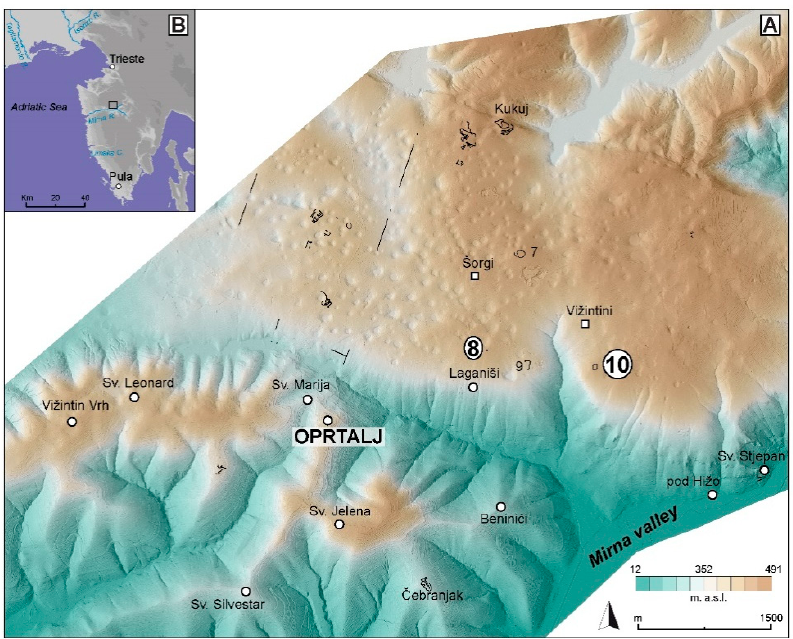
Figure 1. ( A ) Position of the investigated sites 8 and 10, main archaeological sites (white dots and black lines; see Bernardini and Vinci [23]) and modern localities mentioned in the text (white rectangles). ( B ) Position of the area in the Istrian peninsula.